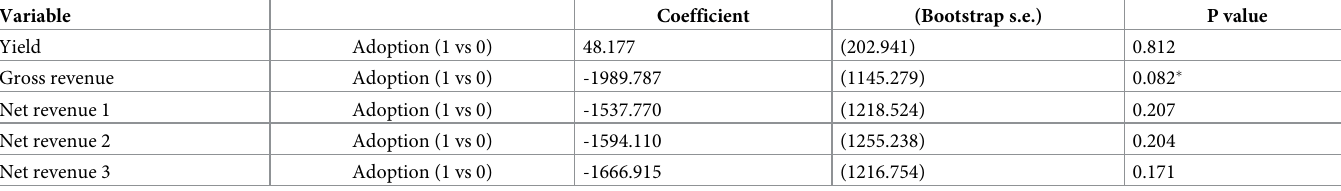
Table 8. PSM model using kernel matching that compares adopting and not-adopting fields in terms of yields, gross revenues, and net revenues per